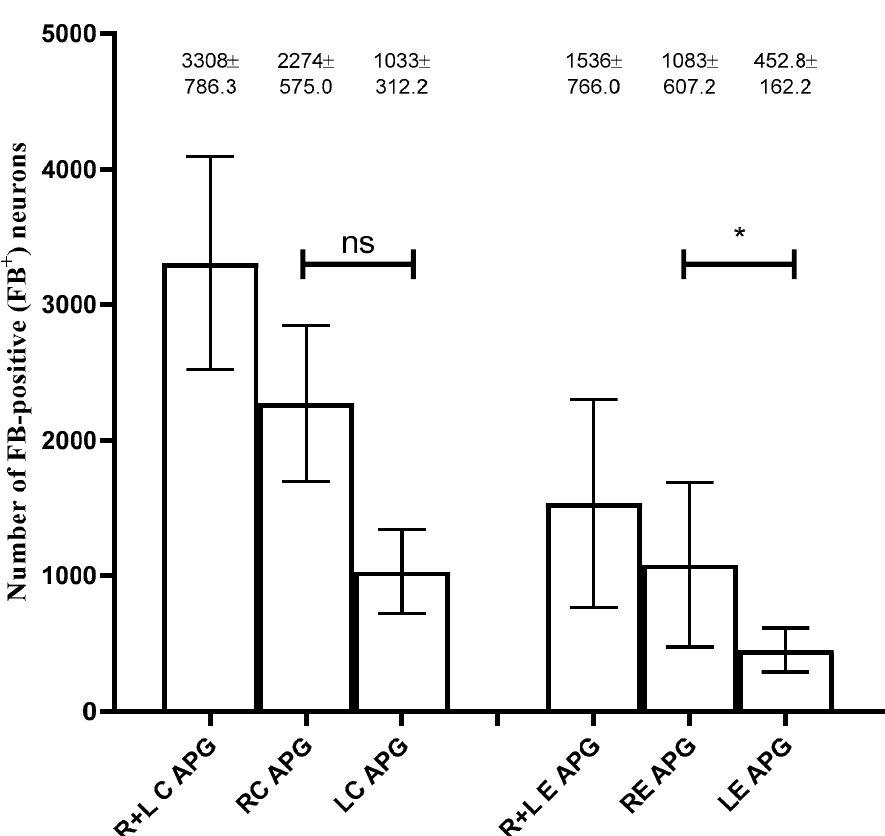
Figure 1. Total number of Fast Blue-positive (FB+) neurons ( ± SEM) in the anterior pelvic ganglia- anterior pelvic ganglia (APG) before-control (C) and after-experimental (E) unilateral axotomy. Bar diagram showing the distribution of the urinary bladder-projecting neurons in the left (L), C and E and right (R) C and E APG. Numerical data are given above the bars; “*”,-differences significant at p ≤ 0.05.